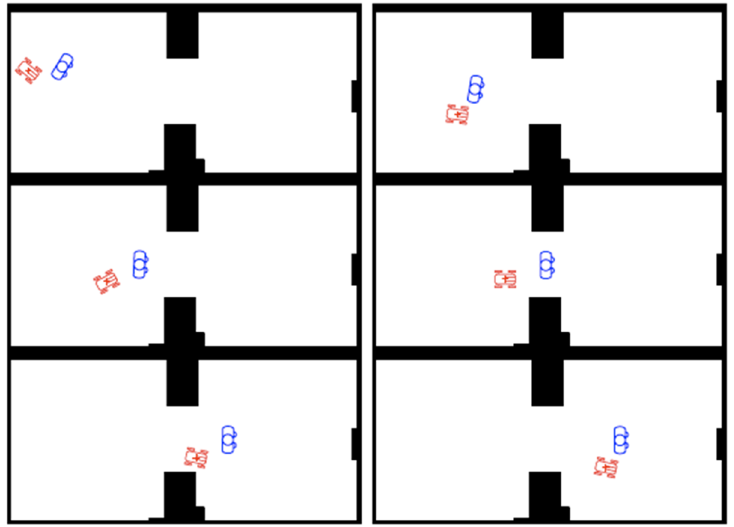
Figure 18. From top-left to bottom-right: sequence of a robot following a human with the FM 2 -based robot formation motion-planning algorithm.